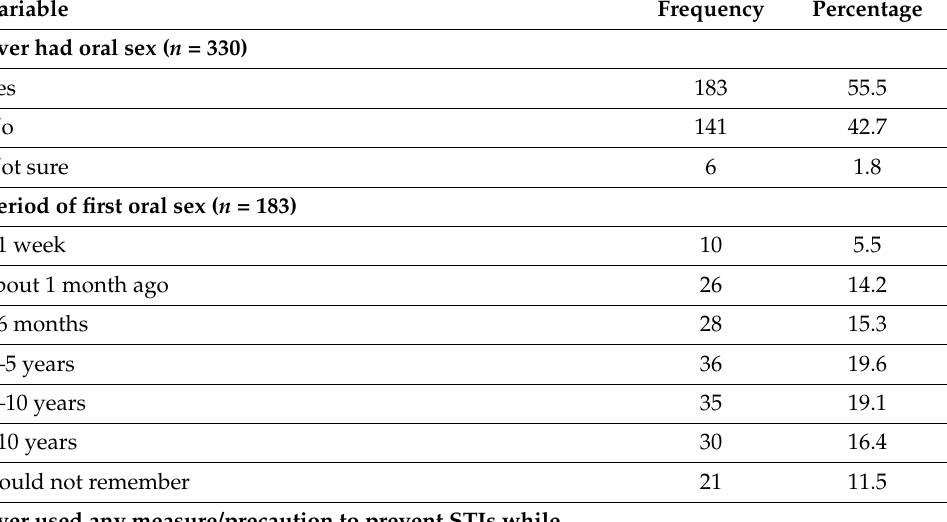
Table 3. Oral sex history, the prevention practices among